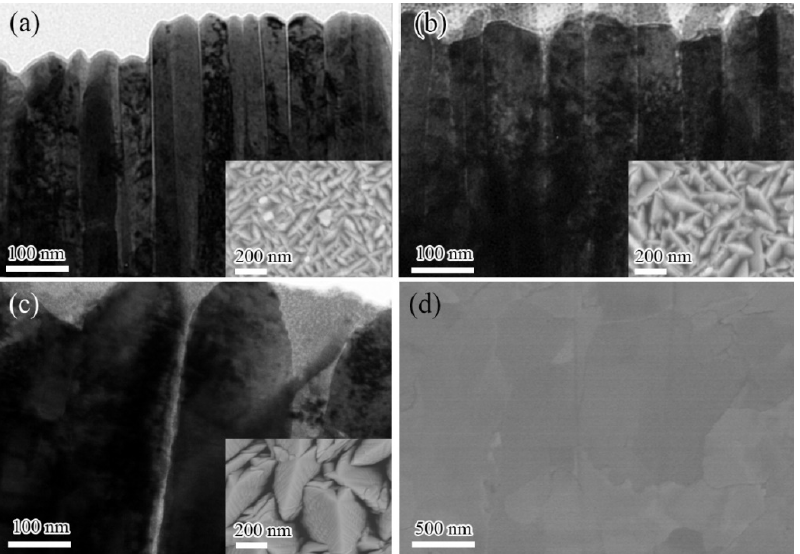
Figure 2. The XTEM image of the W-150W-1 ( a ), the W-50W-1 ( b ), the W-150W-10 ( c ) film, and the surface SEM image of the commercial bulk W ( d ); insets show the corresponding surface SEM images.